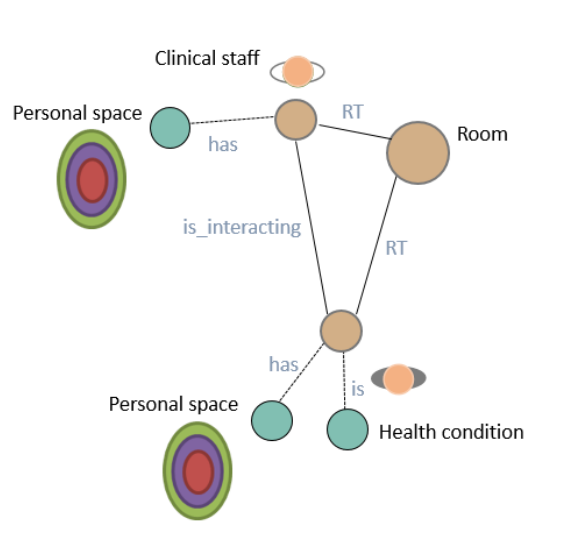
Figure 6. Unified representation as a multi-labeled directed graph. Edges labeled as has and is interacting denote logic predicates between nodes. Edges starting at room and end at senior and clinical staff are geometric relations and encode a rigid transformation RT between